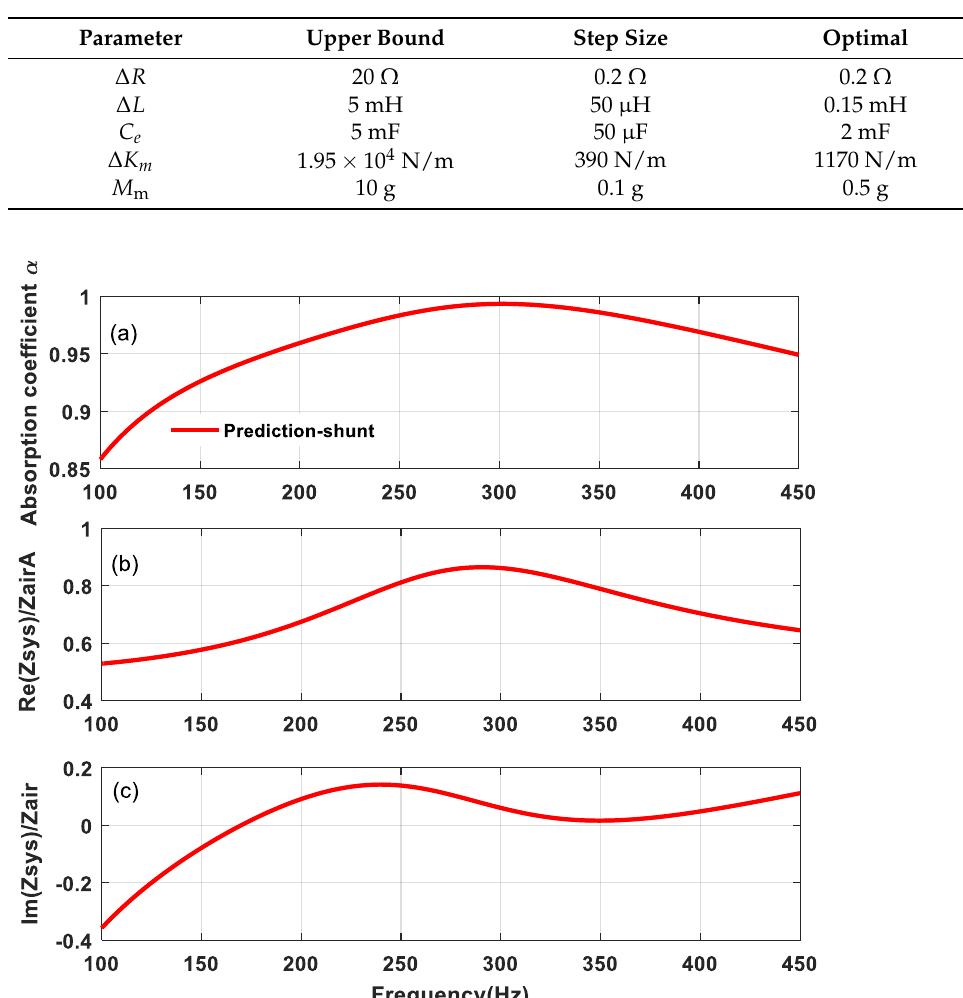
Table 3. Parameter upper bounds and step size settings.